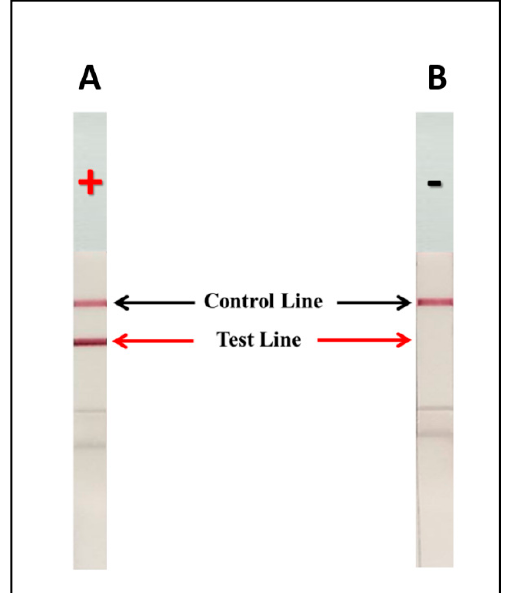
Figure 2. Depiction of the mAb 18B7 sandwich ICT strip with or without detection of cryptococcal capsular antigen. ( A ): a positive result (+) showing intense signals at both the test and at the control lines. ( B ): a negative result ( − ) showing signal only at the control line.